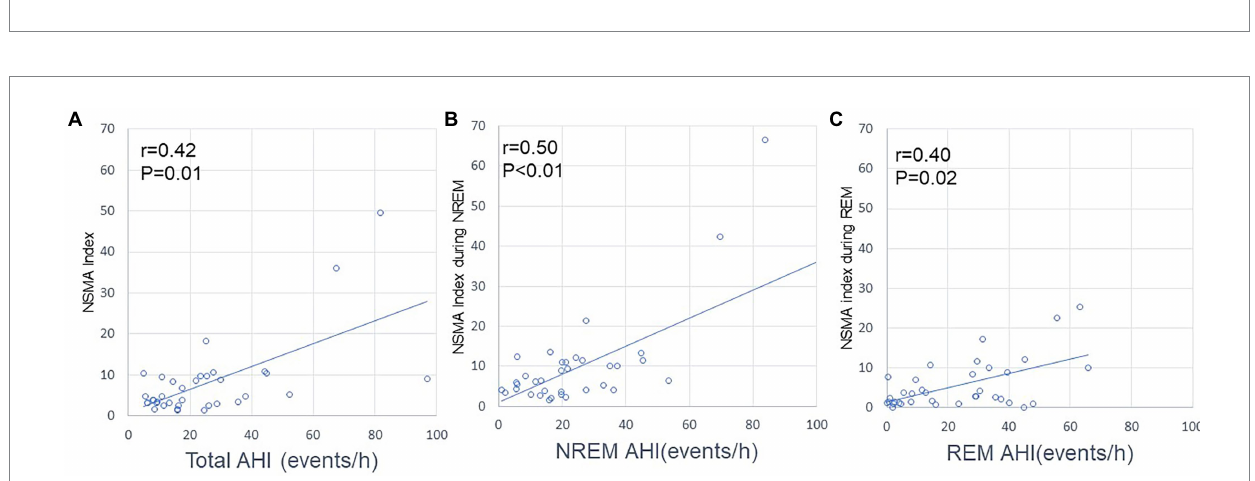
FIGURE 3 Relationships between AHI and the RMMA index. (A) Relationship between AHI and the RMMA index for the whole night. (B) Relationship between AHI and the RMMA index during NREM sleep. (C) Relationship between AHI and the RMMA index during REM sleep. No correlation was observed between AHI and the RMMA index.